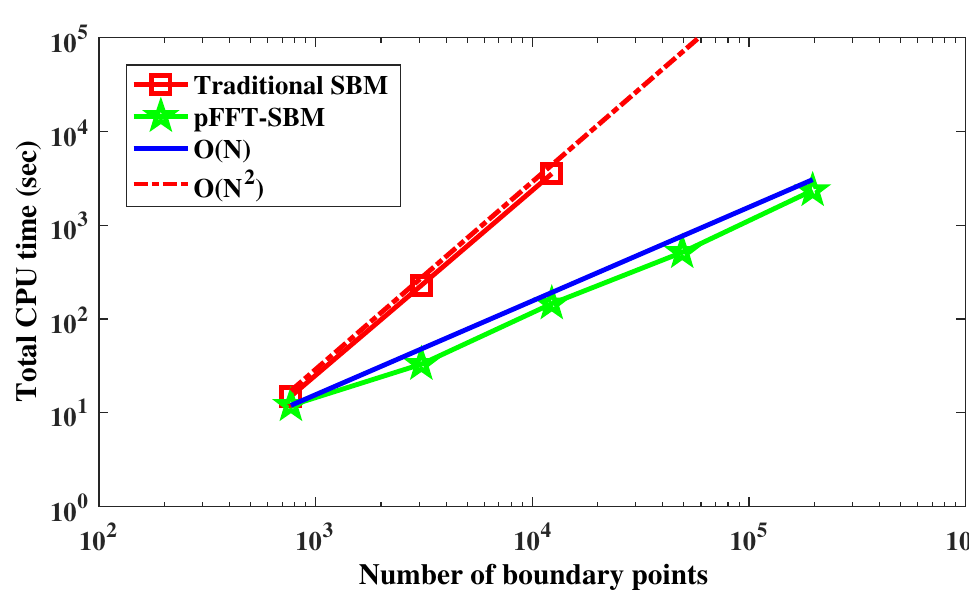
Figure 3. Total CPU time versus the problem size for example